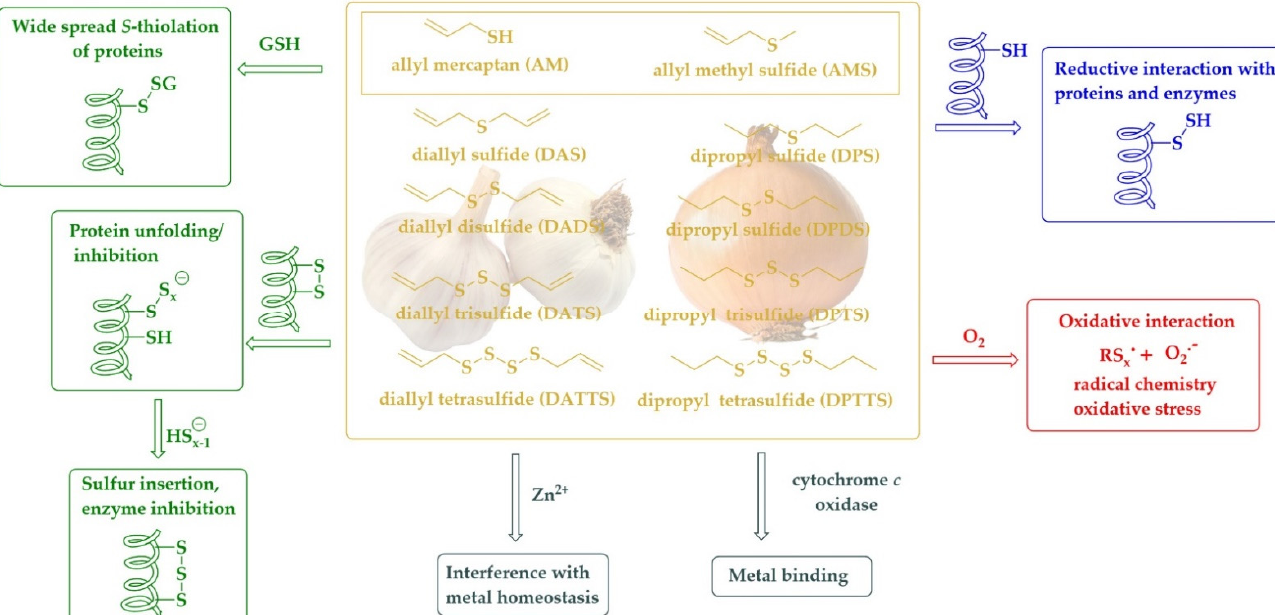
Figure 3. Allyl and propyl mono- and polysulfides found in garlic and onion may serve as multi- functional agents able to interact with thiol residues of proteins and enzymes, interfere with metal homeostasis, bind to metals, and induce oxidative stress via oxidative interactions.